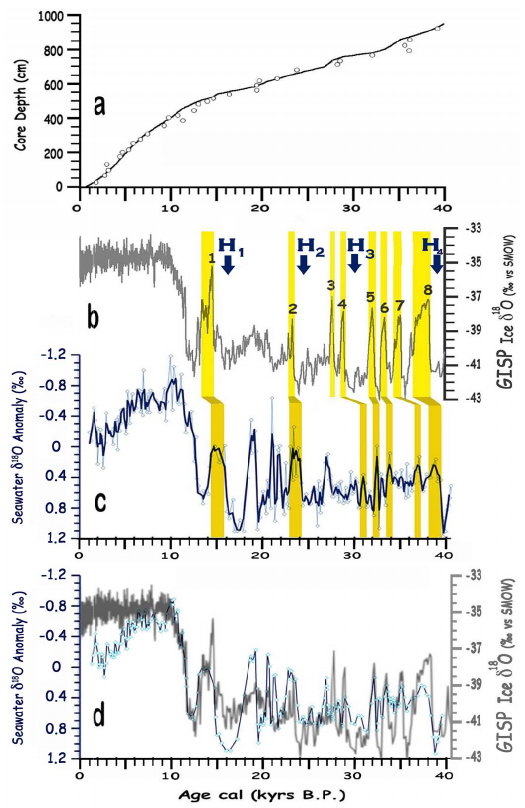
Fig. 3. (a) MD77-176 core depth versus age (circles represent 14 C ages converted into calendar ages using the Calib 4.1 program (Stu- iver and Reimer, 1993; Stuiver et al., 1998) after 20kyr 14 CBP and the Fairbanks et al. (2005) calibration before. The line represents the age model developed assuming that changes in the northern An- daman Sea and GISP2 are in phase and synchronous); (b) Green- land ice core record GISP2: ice δ 18 O versus age; (c) MD77-176 core δ 18 O sw anomaly versus calendar age obtained using the Fair- banks et al. (2005) calibration. A smoothed curve obtained using 5-point moving-average is also shown. Coloured areas indicate cor- relations that we made between the Greenland and northern An- daman Sea records assuming that climatic events are in phase and synchronous in the two regions; (d) Comparison between GISP2 ice δ 18 O and the smoothed δ 18 O sw anomaly curve of the core MD77- 176, with the Bay of Bengal age model tuned on that of the GISP2